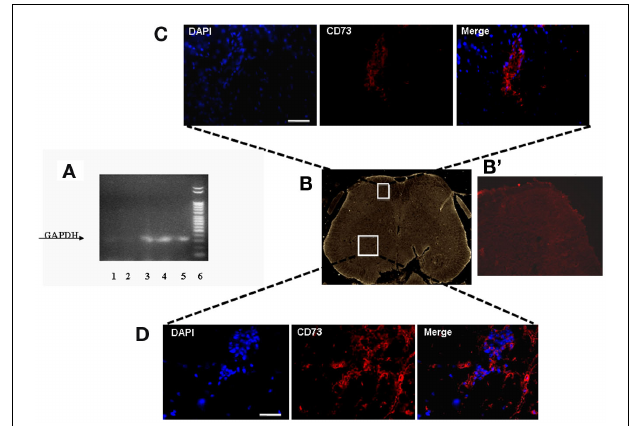
FIGURE 2 | (A) Representative agarose gel blot analysis for human GAPDH gene of 30days-SNI/hMSCs mice following RT-PCR is shown. Lane (1) lung; lane (2) sciatic nerve; lane (3) ventral L4–L5 spinal cord and (4) dorsal L4–L5 spinal cord; lane (5) pre-frontal cortex; lane (6) DNA ladder marker.The analysis of mRNA levels was carried out by the “Gel Doc 2000 UV System” (Bio-Rad, Hercules, CA, USA). RT-PCR analysis revealed a preferential accumulation of hMSCs to the L4–L5 spinal cord (both ventral and dorsal areas) and pre-frontal cortex.Very weak band was found from lung. No GAPDH band was detectable in sciatic nerve, thus revealing the specificity of hMSC engraftment at the NP controlling and processing areas. (B) Representative cross-section of mouse whole L4–L5 spinal cord area from hMSC-treated 30days-neuropathic mice (26days post-hMSC injection). (B’) Representative cross-section of mouse whole L4–L5 spinal cord area from vehicle treated 30days-neuropathic mice showing no staining for human specific CD73. (C,D) Human MSCs expressed lineage-specific antigens at 26days post-injection in vivo . Representative fluorescent photomicrograph of hMSCs showing immunocytochemistry for CD73. Area in white rectangle insets is shown: (C) ventral spinal cord; (D) dorsal spinal cord; left: cell nuclei were counterstained with DAPI (blue fluorescence); middle: CD73-positive hMSCs emitted red fluorescence; right: pictures with both red and blue fluorescence were merged. Scale bars: 100 μ